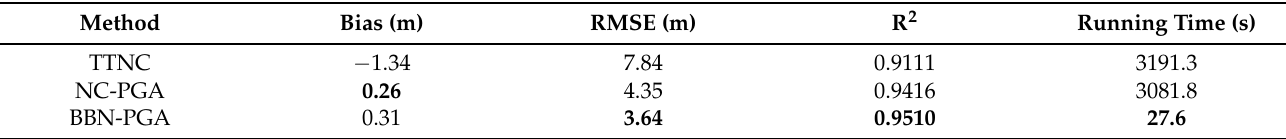
Table 5. Evaluation results of real data